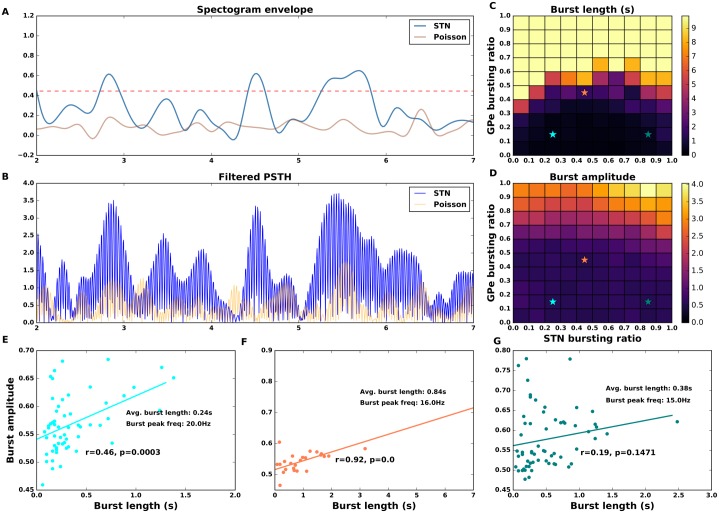
Effect of spike bursting on beta-band oscillation bursts.(A) An example of the amplitude envelope of the beta band (15-20 Hz) oscillations (blue trace). Beta oscillation burst threshold (red dashed line) was determined by averaging the maximum of beta band amplitude envelop for a Poisson process (orange trace) with the same firing rate as the neuron in the STN-GPe network. The averaging was done over Poissonian firing rates corresponding to all GPe and STN spike bursting ratios and 5 trials per STN-GPe bursty ratio combination. (B) Low pass filtered (15-20 Hz band) trace of population firing rate in the STN population in the beta band (15-20Hz). The orange trace shows the population firing rate of the Poisson process with same average firing rate as the STN activity. (C) Beta oscillation burst length as a function of the fraction of spike bursting neurons in the GPe and the STN. (D) Beta oscillation burst amplitude as a function of the fraction of spike bursting neurons in the GPe and the STN. (E,F,G) Correlation between β oscillation burst length and amplitude for three different combinations of FBSTN and FBGPe(marked with cyan, orange and green colors in the pane C. Cyan marker shows beta oscillation burst length and amplitude for 10% of spike bursting neurons in GPe and 20% in STN—this combination of spike bursting neurons gives an average oscillation burst length of 0.24 s which is comparable to experimentally measured values. In panels E-F the p-values are listed to 4 places after decimal point.